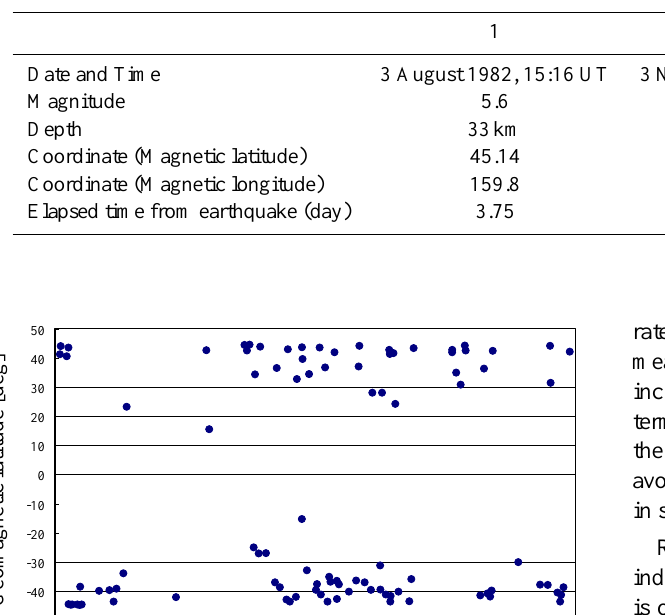
Table 2. Principal parameters of three seismic events (EQ 1 to EQ3) around the orbits 1 and 2 shown in Fig. 4a.